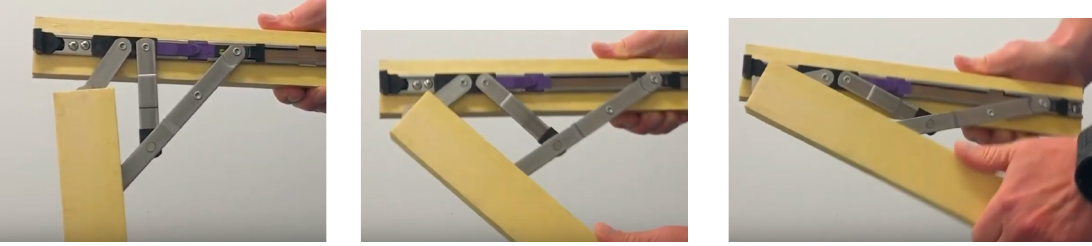
Figure 14. A standard window mechanism uses a slider to open (from [77]).